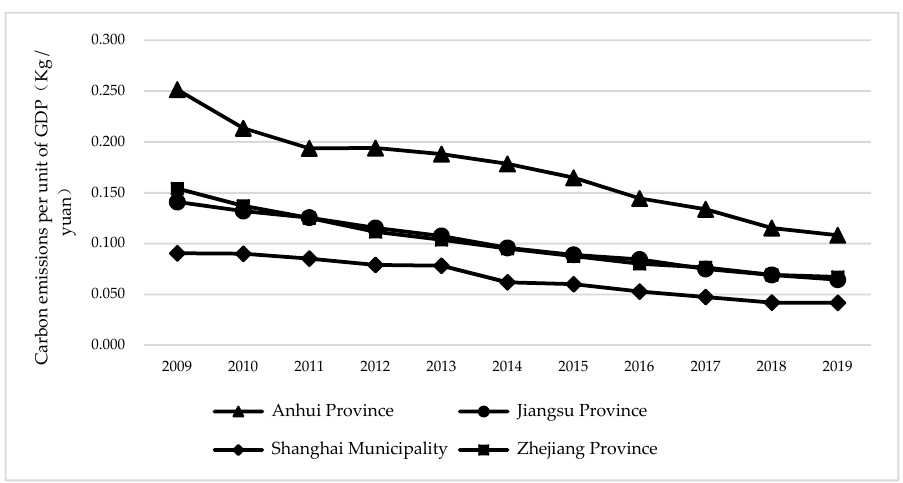
Figure 4. Carbon emission per GDP of three provinces and one city in Yangtze River Delta.